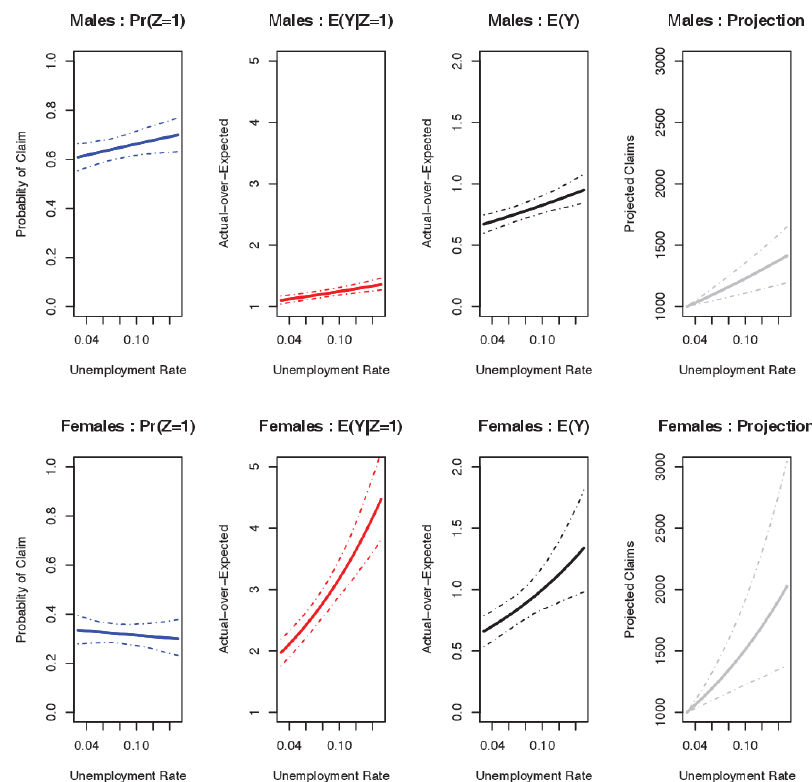
Figure 3. Insured population: hurdle